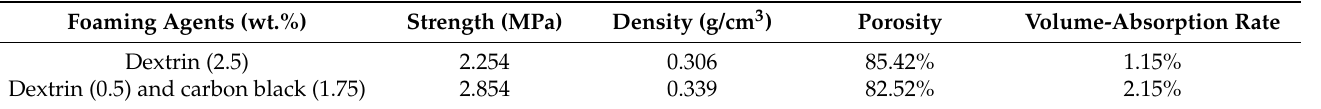
Table 1. Comparison of the oxidation-type foaming agent (dextrin) and a mixture of dextrin and the reduction-type foaming agent (carbon) [17].